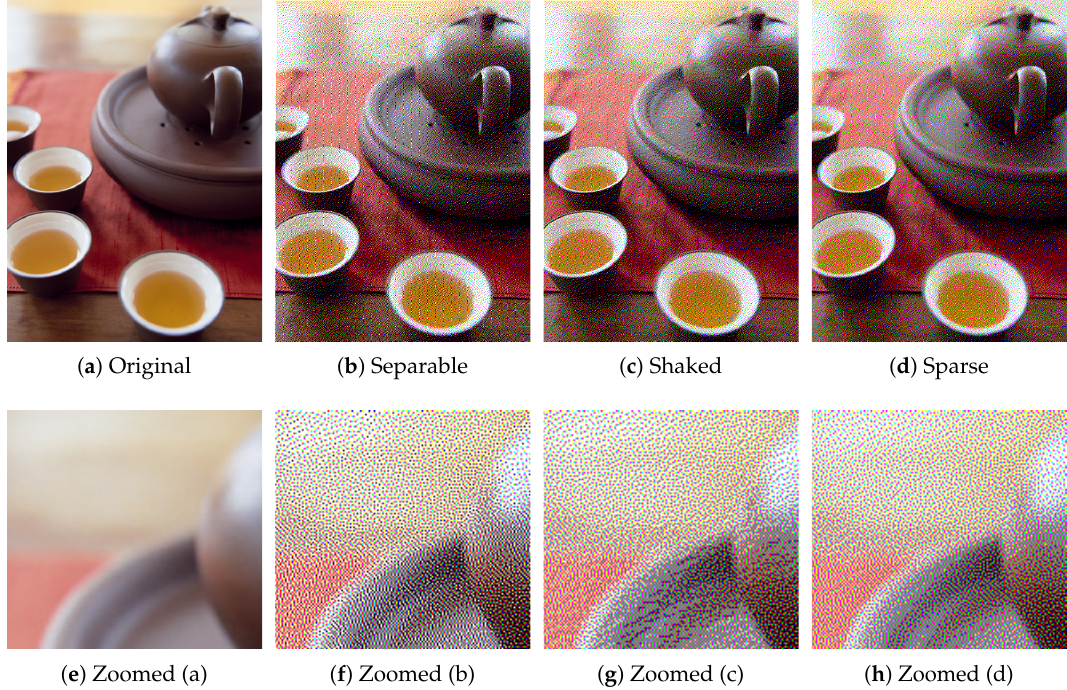
Figure 12. Color image halftoning with zoomed